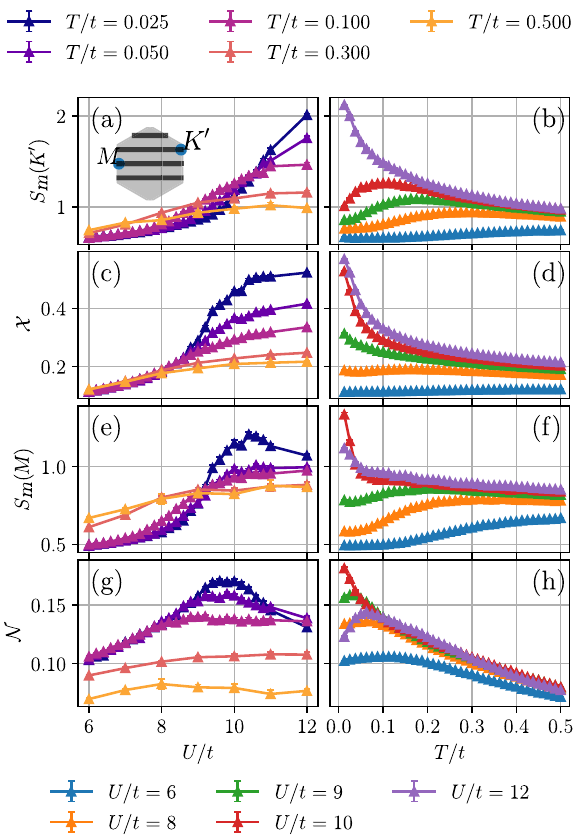
FIG. 6. Magnetic ordering as a function of interaction strength U=t (left) and temperature T=t (right) on the 16 × 4 YC4 cylinder from METTS. Simulations have been performed with a maximal 3000 . (a),(b) Magnetic structure factor bond dimension D max ¼ S K 0 Þ indicating 120° N´eel order. The inset in (a) shows the m ð momenta resolved by the YC4 cylinder, and the position of the ordering vectors K 0 and M (c),(d) chiral susceptibility X as defined in Eq. (17). Chiral correlations build up in both the intermediate as well as the strongly coupled regime at lower temperature. (e),(f) Magnetic structure factor S m ð M Þ indicative of collinear stripy antiferromagnetic order. (g),(h) Nematic spin correlation N , as defined in Eq. (19), is pronounced only in the intermediate coupling